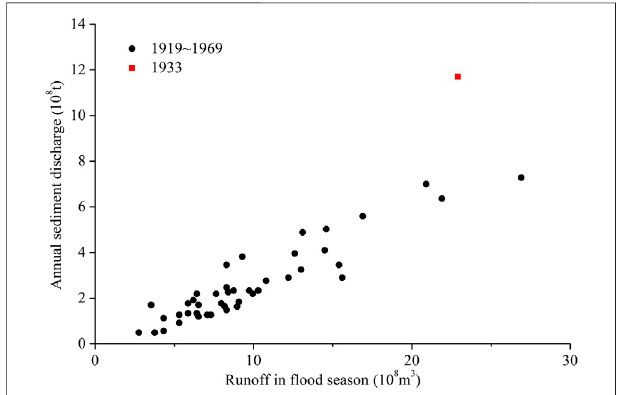
FIGURE 7 | Comparison of runoff in the fl ood season and annual sediment discharge relationships at the Zhangjiashan station in the Jinghe River Basin in 1933 and other